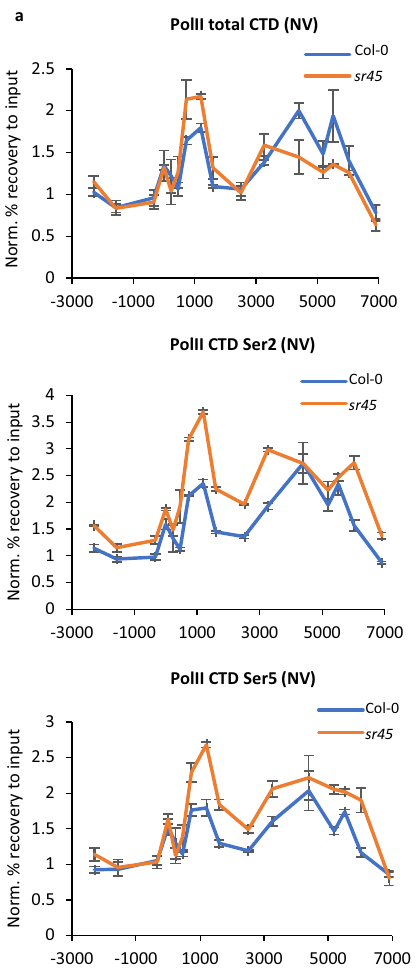
b . SR45-dependent changes in active/repressive histone modi fi cations. X-axis shows the midpoint of the amplicon at FLC , amplicon 0=TSS. Y-axis corresponds to % recovery to input values normalized to H3 enrichment. NV non-vernalized; N =3 biological replicates; error